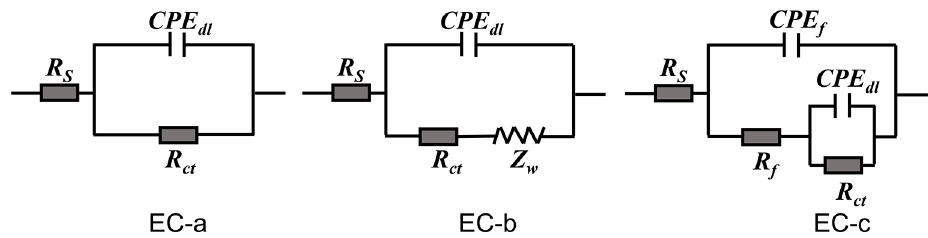
Figure 8. Equivalent electric circuits used for modeling the EIS results of Figure 7.